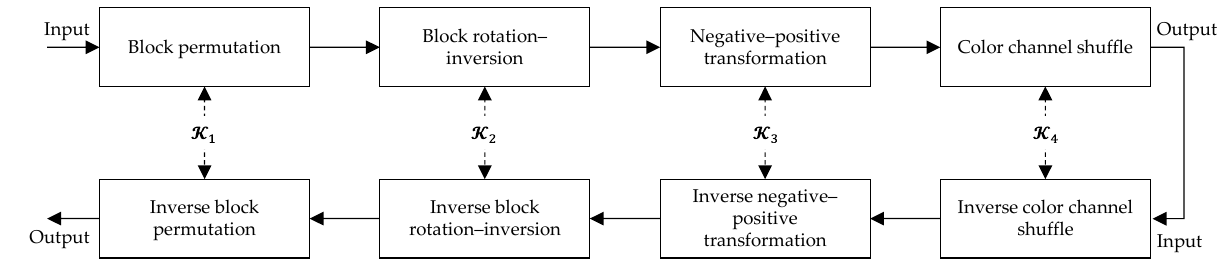
Figure 3. An illustration of block-based CPE encryption and decryption processes, where each 𝓚 𝒊 , 𝑖 = 1, … , 4 is a set of keys used in each step to process the color channels.